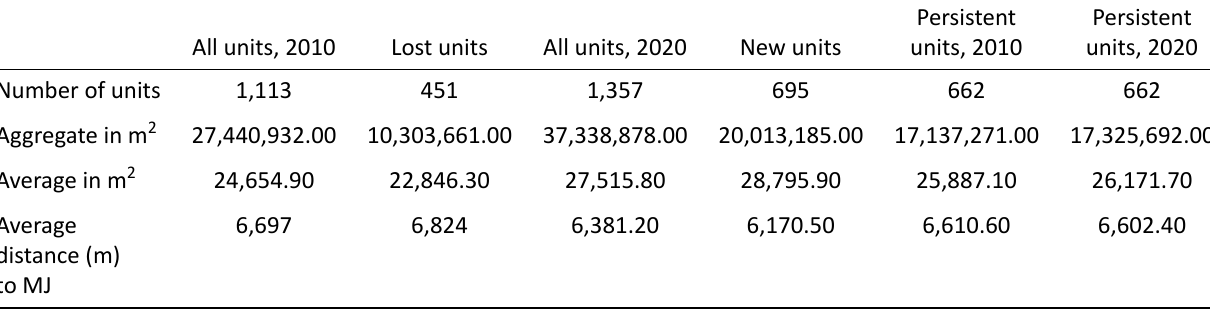
Table 4. Characteristics of new, lost, and persisting LDWs,